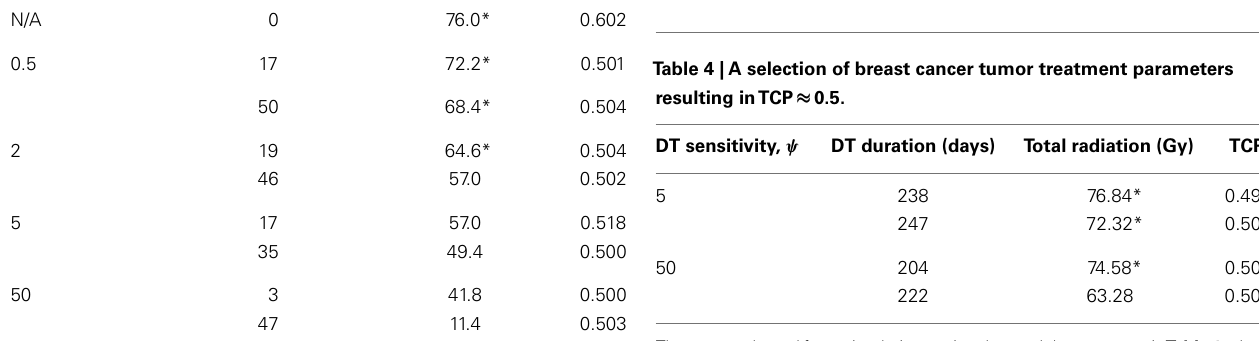
FIGURE 4 | (Breast)TCP for various regimens of differentiation therapy (DT), radiation therapy (RT), and combination therapy, as applied to a simulated breast cancer tumor. The RT protocol and tumor parameters are described in the corresponding result section. (A) Simulations with CSC